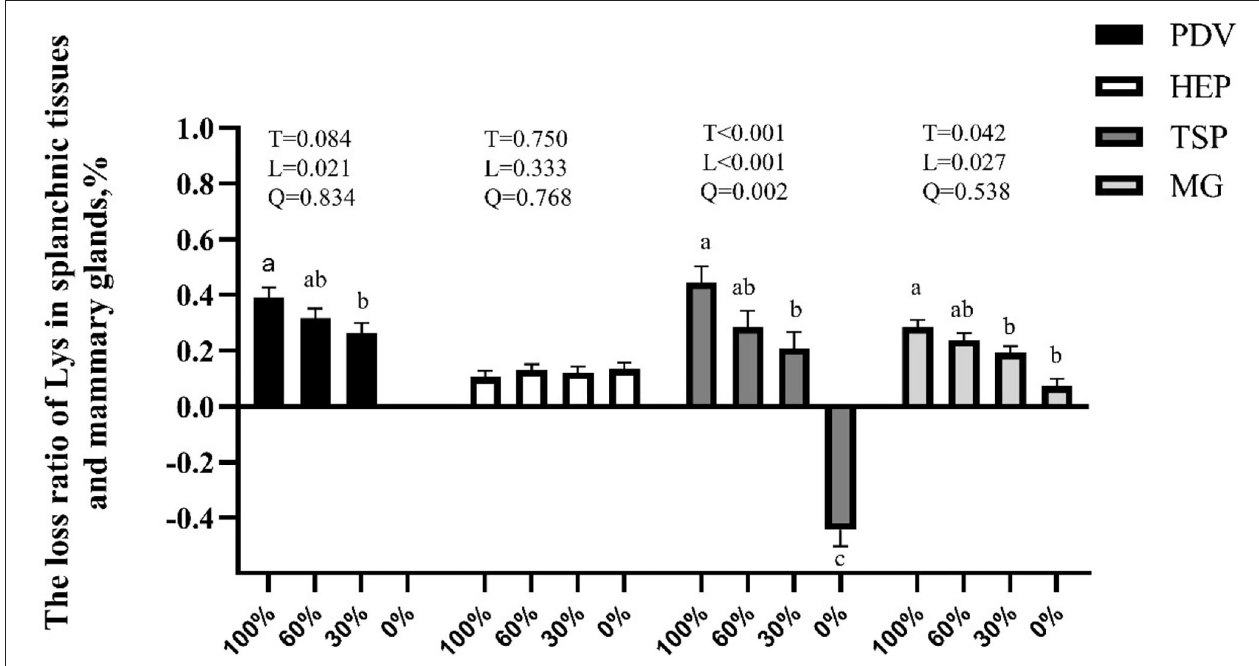
FIGURE 2 | Effects of graded removal of Lys from the amino acid (AA) mixture infused into abomasum on the loss ratio of Lys in splanchnic tissues and mammary glands of lactating goats. PDV, portal-drained-viscera; HEP, hepatic tissues; TSP, splanchnic tissues; MG, mammary gland. a96c Least square mean within a row with a different superscript indicate a significant difference ( p < 0.05) between 100, 60, 30, and 0% of